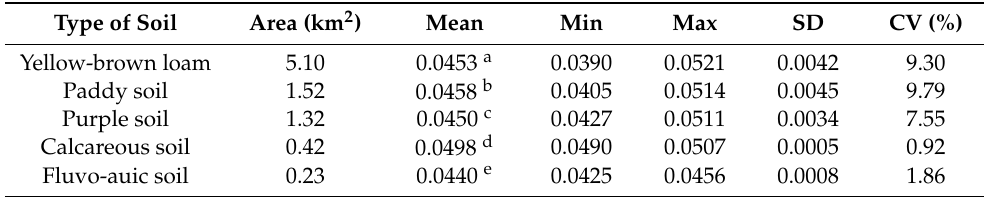
Table 4. Statistics of K values for different soil types (t · hm 2 · h/(hm 2 · MJ · mm). Type of